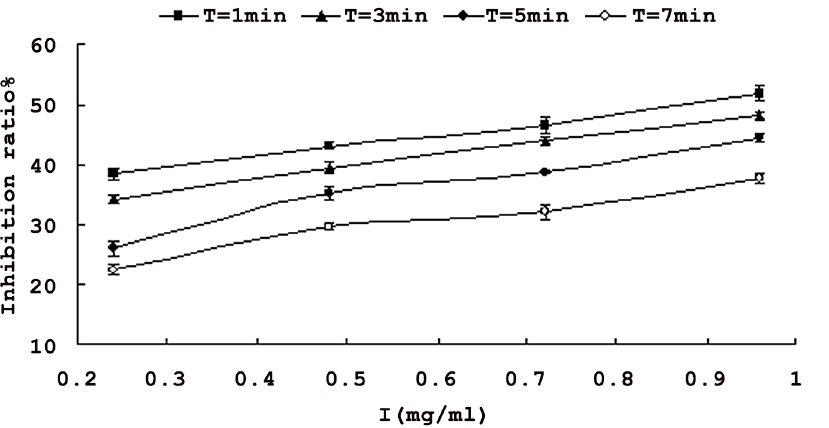
Figure 2. Inhibitory effect of the saponins from XanthocerasSorbifoli nutshell on activity of tyrosinase. Each value is expressed as mean ± standard deviation (n=3).